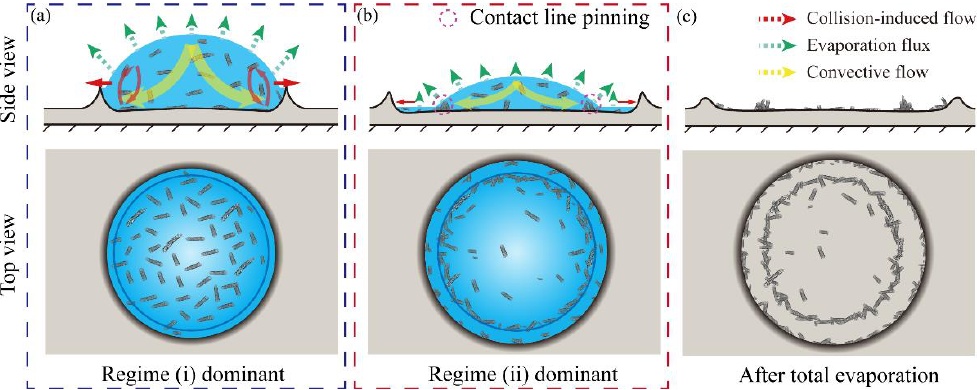
Figure 5. Schematic of the spreading, evaporation, and particle migration process of a single CNT droplet. ( a ) The regime-(i)-dominant spreading. ( b ) The regime-(ii)-dominant spreading. ( c ) After total evaporation and solute migration.